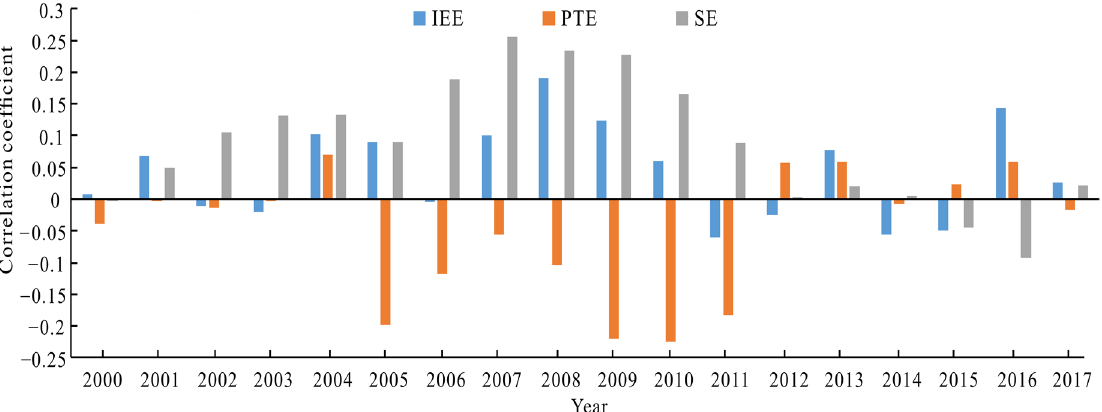
Figure 1. Temporal correlation intensity between IEE, PTE, SE, and carbon emissions.